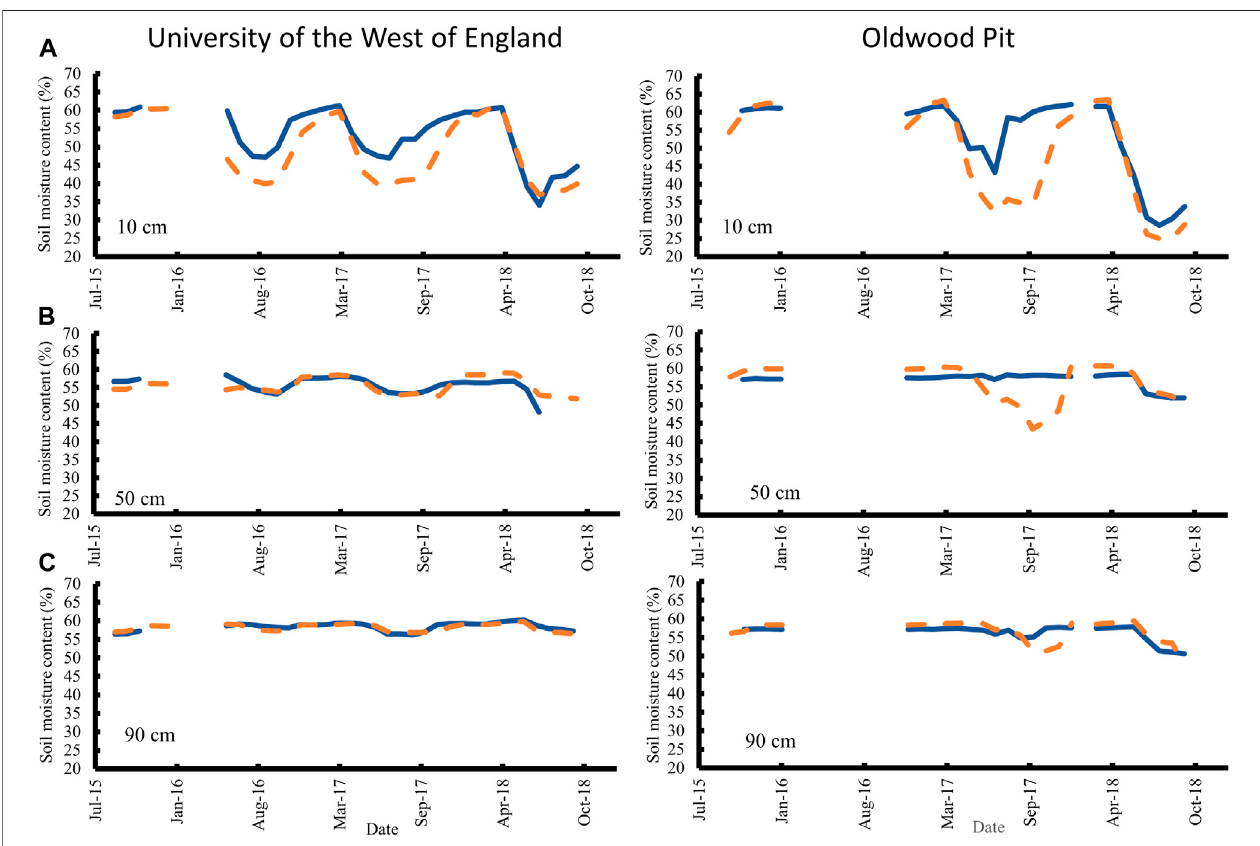
FIGURE 5 | Monthly average soil moisture content (%) at (A) 10 cm, (B) 50 cm, and (C) 90 cm for Control and RR plots at UWE and OWP.